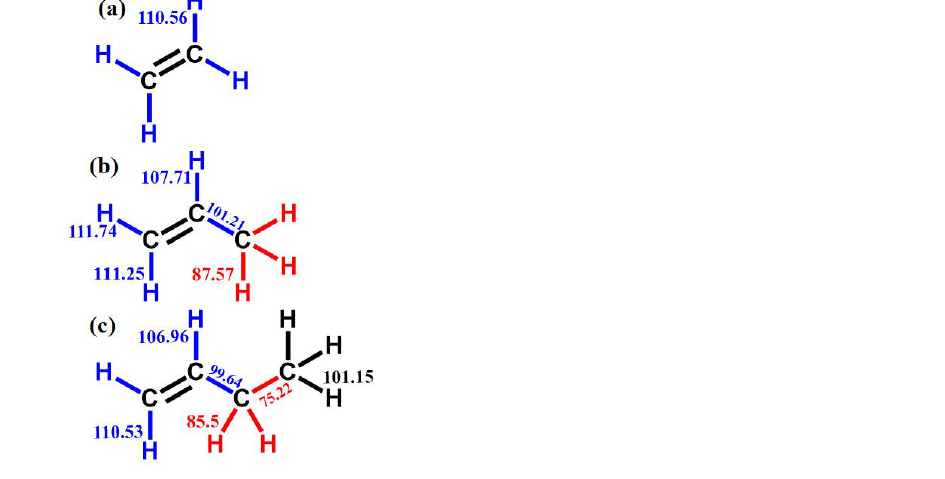
Figure 2. Molecular structure and BDEs of ethylene ( a ), propene ( b ) and 1-butene ( c ) at 298.15 K. The BDEs of ethylene, propene and C–C bonds in 1-butene were adopted from the ATcT database [56] while the C–H bonds in 1-butene were taken from Li et al.